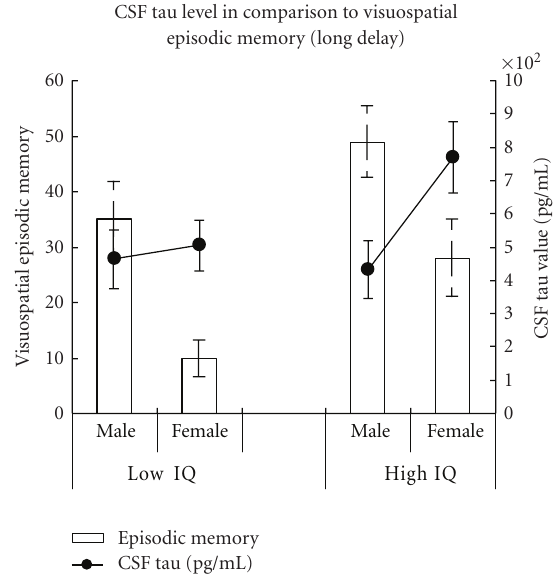
Figure 1: Visuospatial episodic memory performance (bars indi- cate % of maximum score) in comparison to CSF tau values (lines) in male and female AD patients. Higher memory scores indicate better performance. Higher CSF tau values indicate more advanced disease